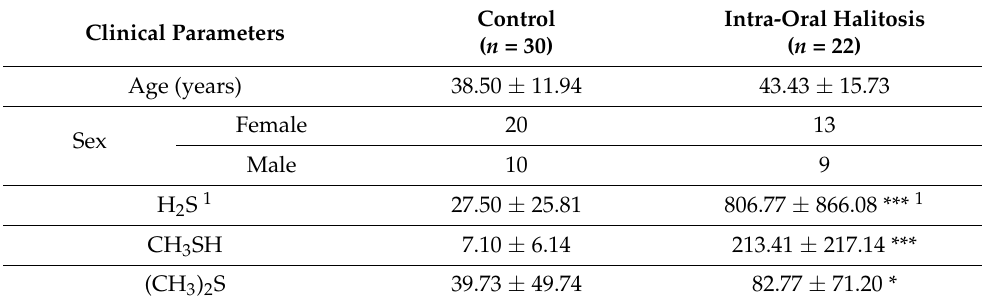
Table 1. Demographic and clinical characteristics of the study